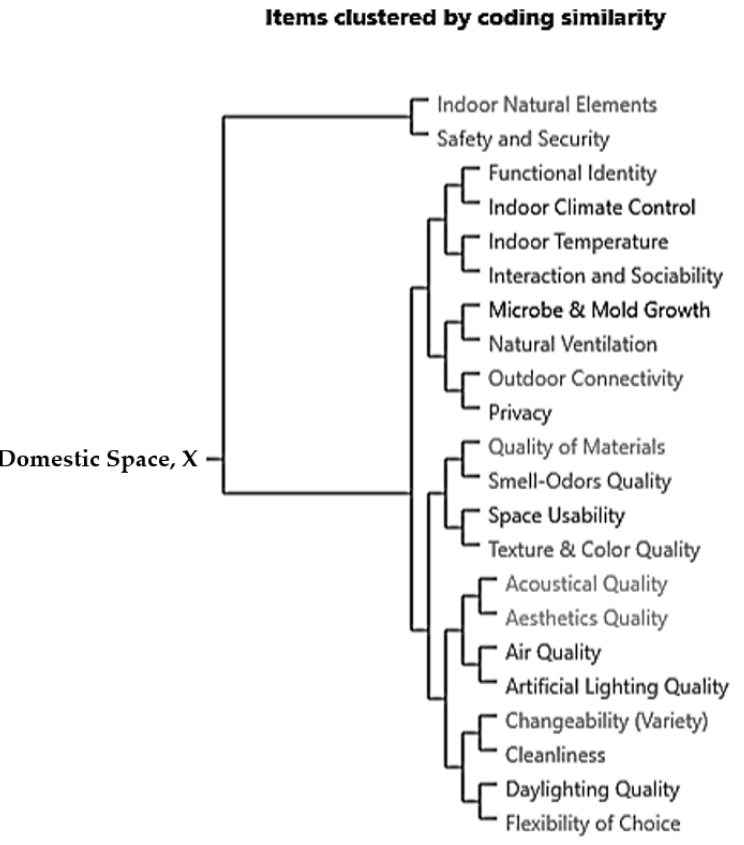
Figure 11. Contextual correlation of spatial and environmental design factors. (Source: author; based on analysis).